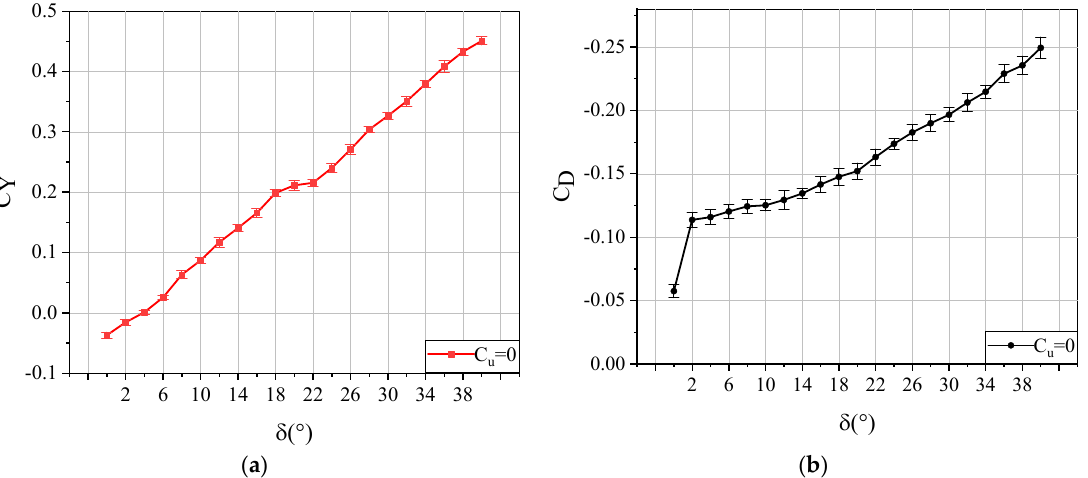
Figure 6. Aerodynamic curve of uncontrolled vertical tail model: ( a ) C Y curve; ( b ) C D curve ( β = 0°, Re = 2.12 × 10 5 ).